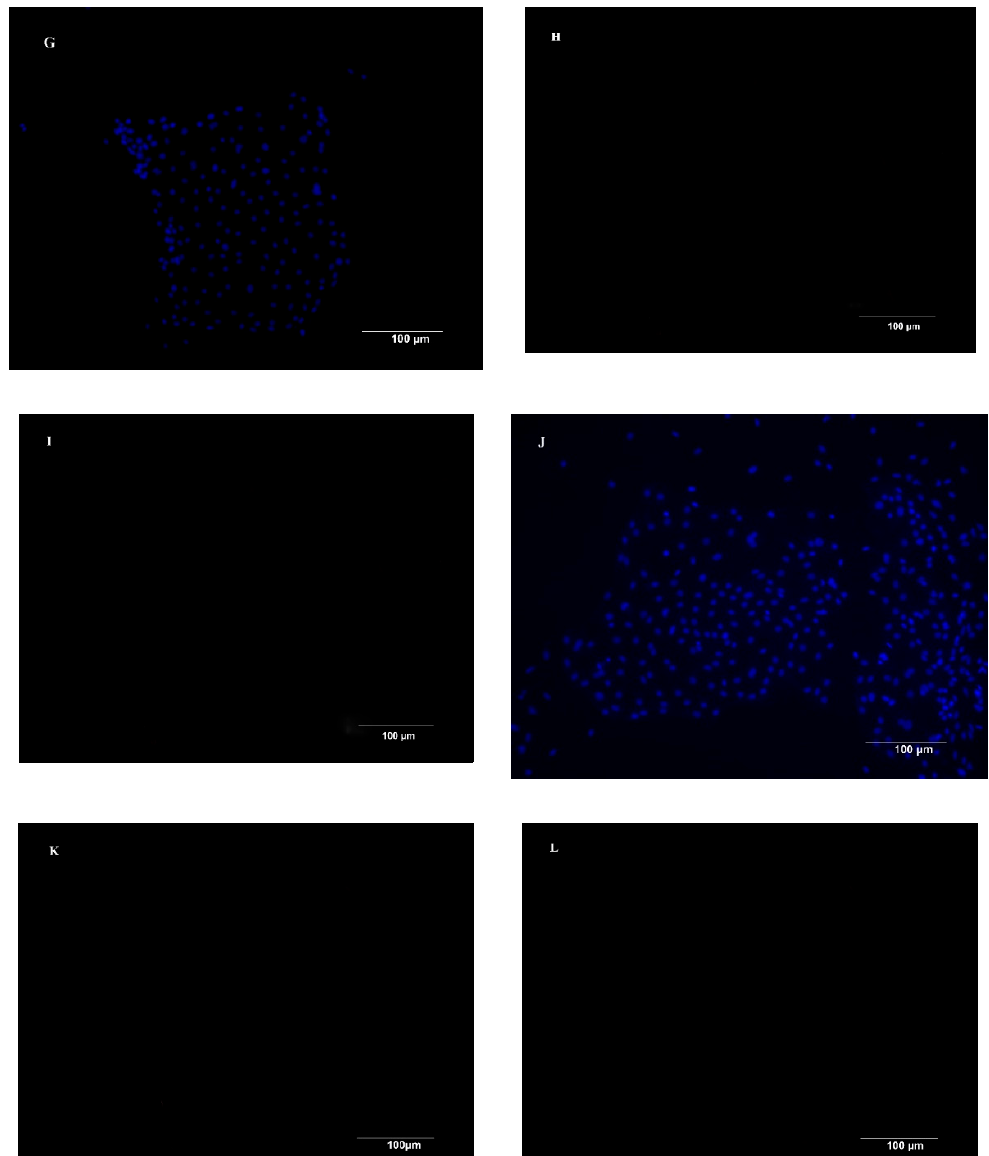
Figure 1. Morphological features and immunofluorescence staining of primary chicken intestinal epithelial cells (IECs). ( A ) Epithelial cells were isolated in cell clusters. ( B ) Primary chicken IECs at 24 h post-seeding. The image shows cobblestone-shaped IECs radially growing from the center of the crypt (Cr) and cell clusters connecting. ( C ) Primary chicken IECs culture within 4–5 days post-seeding. Image shows a confluent chicken IECs. ( D , G , J ) Nuclei were stained (blue). ( E ) Immunostaining against cytokeratin-18 (green) at 3 days post-seeding. ( F ) Immunostaining against vimentin (red, the arrows in the figure) at 3 days post-seeding. ( H ) Primary chicken IECs presented in the image ( G ) were incubated only with the primary antibody of cytokeratin without the secondary antibody to serve as a primary antibody control. ( I ) Primary chicken IECs presented in the image ( G ) were incubated first with bu ff er only without the primary antibody of cytokeratin-18 and subsequently with secondary antibody to serve as a secondary antibody control. ( K ) Primary chicken IECs presented in the image ( J ) were incubated only with the primary antibody of cytokeratin without the secondary antibody to serve as a primary antibody control. ( L ) Primary chicken IECs presented in the image ( J ) were incubated first with bu ff er only without the primary antibody of cytokeratin-18 and subsequently with secondary antibody to serve as a secondary antibody control.